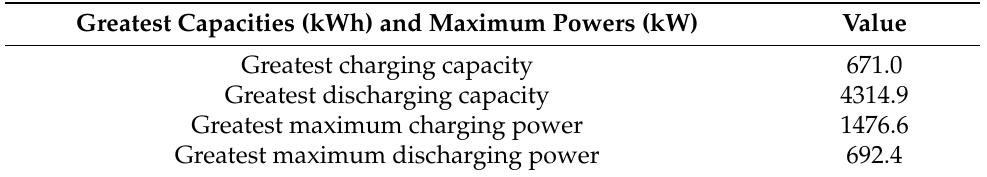
Table 4. Greatest capacities and maximum